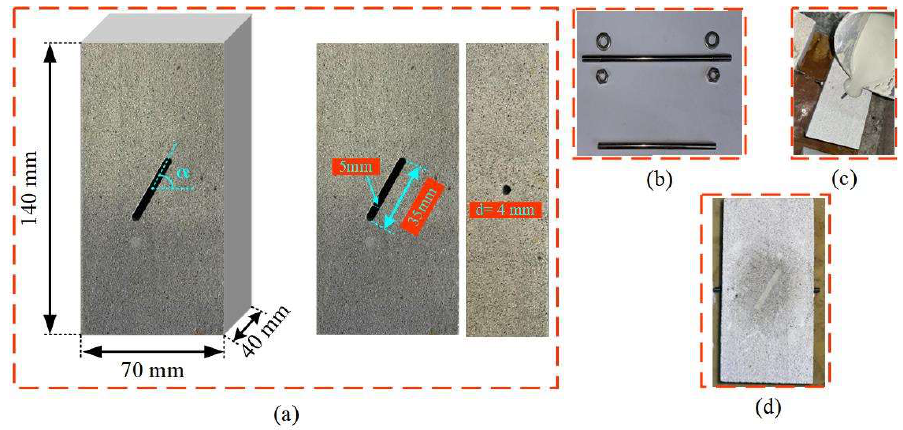
Figure 1. Sample preparation: ( a ) sample geometry and size; ( b ) two types of rock anchor; ( c ) weak interlayer grouting; ( d ) final sample.